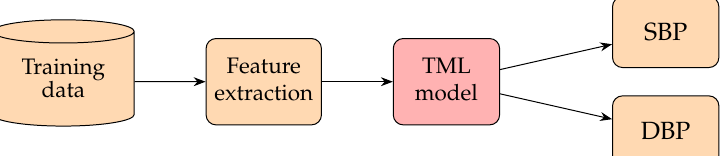
Figure 8. A pipeline of traditional machine learning (TML) methods for PPG signals. Features inside training data are extracted based on various author-preferred criteria (e.g., highest correlation with the ground truth BP) to train their studied TML models and give the predictions for SBP and